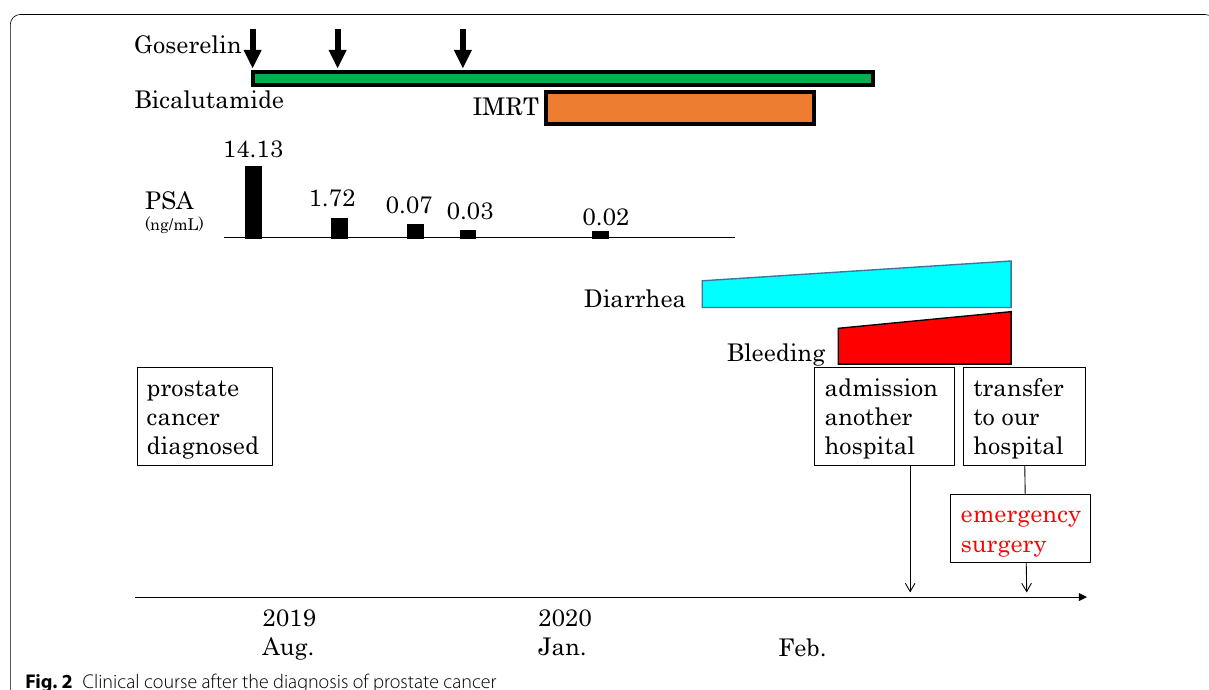
Fig. 2 Clinical course after the diagnosis of prostate